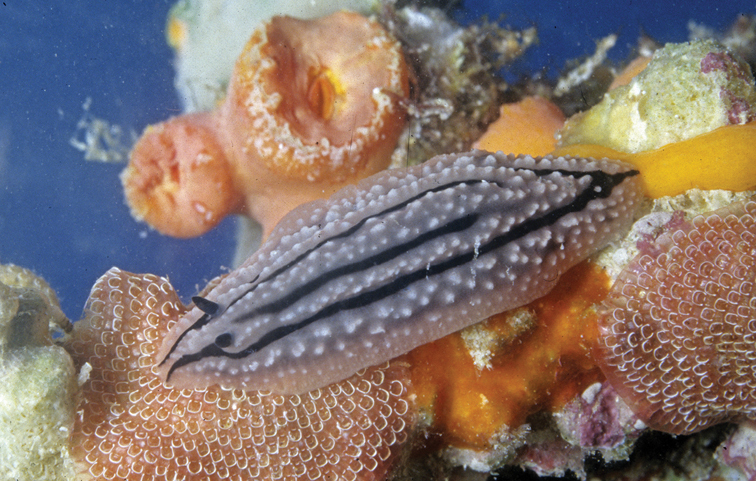
Phyllidiopsis gemmata, Maldives, photo: J Hinterkircher (no spcm).